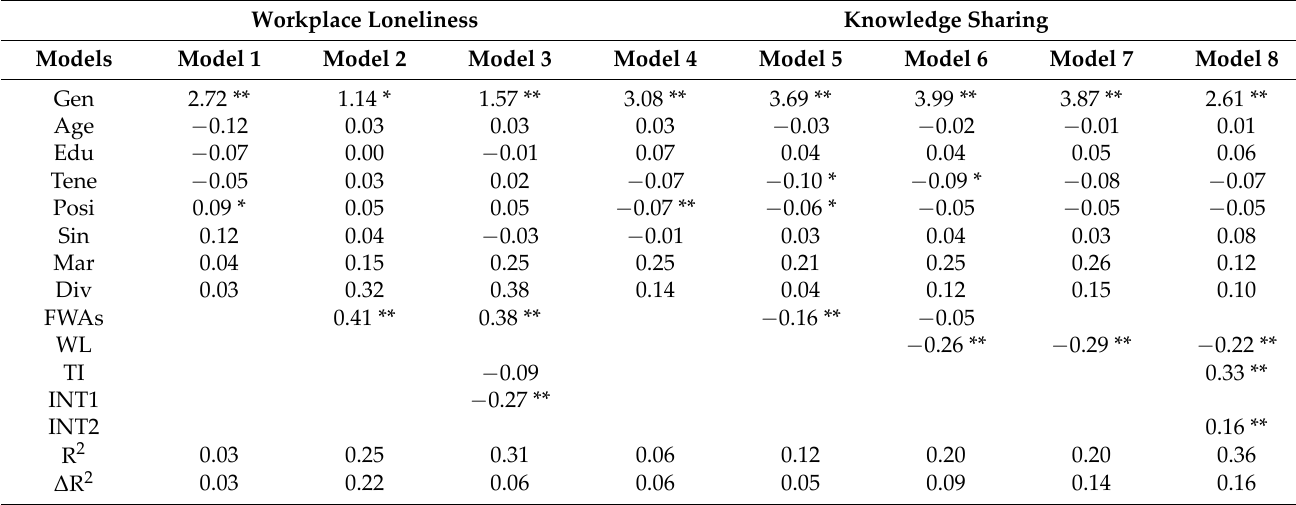
Table 5. Hierarchical regression analyses of Study